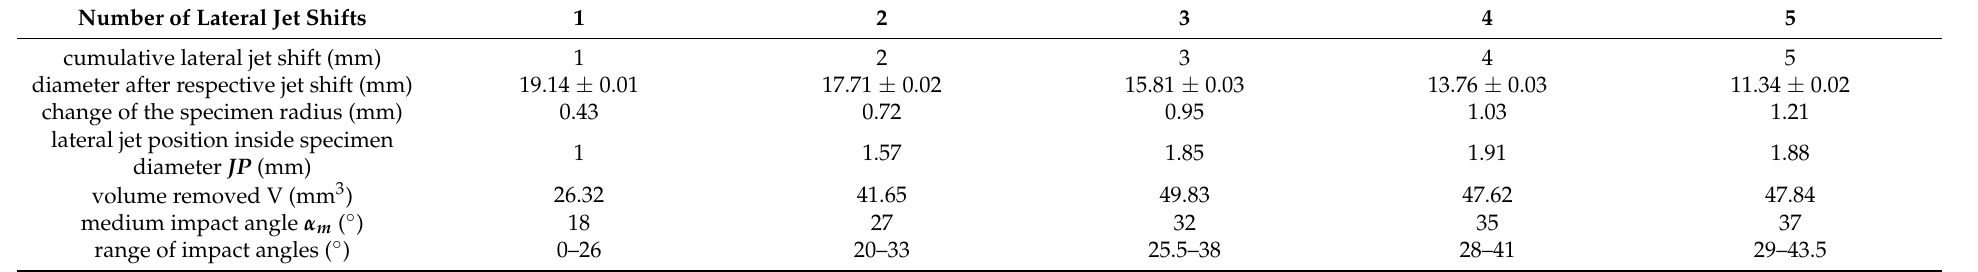
Table 10. Experimental results with the lateral jet shift 1